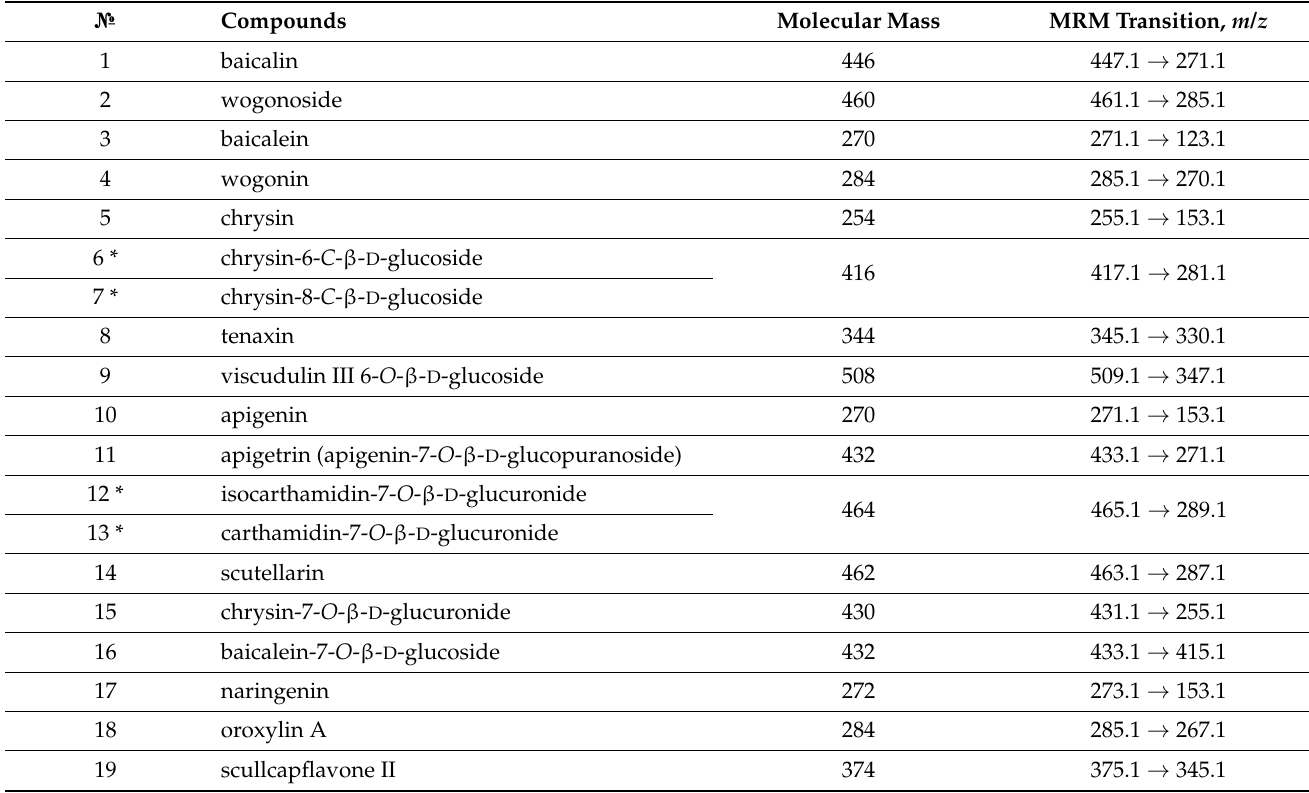
Table 2. Identification of flavones in hairy roots S. baicalensis , S. lateriflora , S. przewalskii and S.pycnoclada by